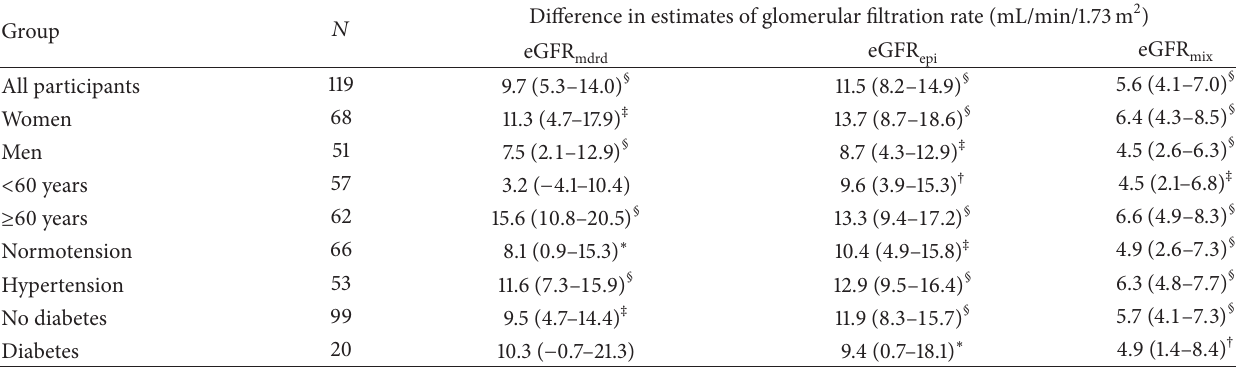
Table 2: Differences between various estimates of GFR with eGFR derived from serum cystatin C as referent method. Group